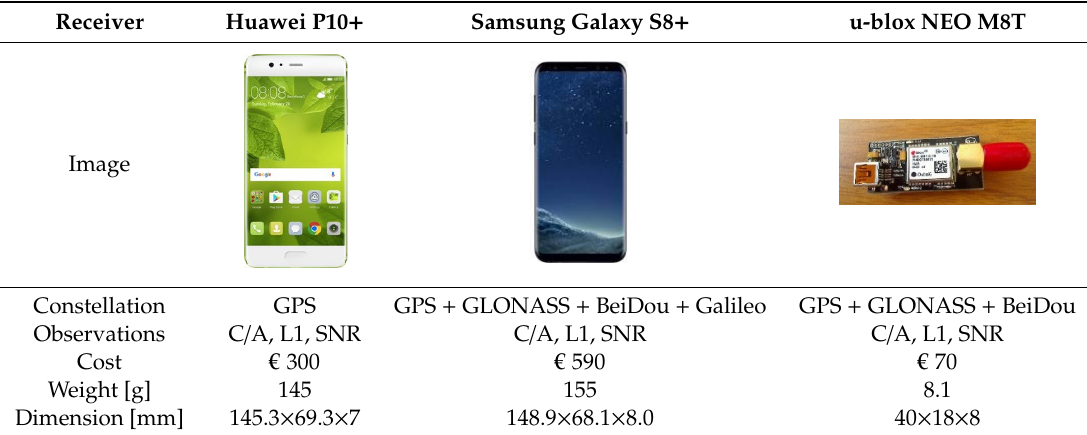
Table 1. The instruments used in these tests.